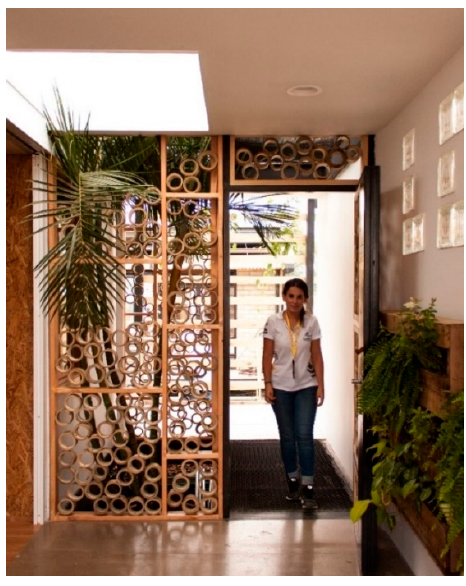
Figure 13. Photo of the entrance hall and access to the prototype.